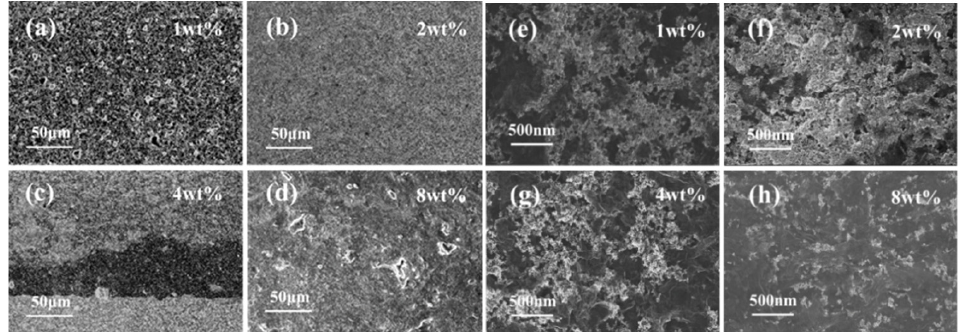
Figure 4. SEM images of SnO 2 /rGO nanocomposites. SEM images of ( a ) 1 wt% SnO 2 /rGO, ( b ) 2 wt% SnO 2 /rGO, ( c ) 4 wt% SnO 2 /rGO, and ( d ) 8 wt% SnO 2 /rGO at low magnification; SEM images of ( e ) 1 wt% SnO 2 /rGO, ( f ) 2 wt% SnO 2 /rGO, ( g ) 4 wt% SnO 2 /rGO, and ( h ) 8 wt% SnO 2 /rGO at high magnification.